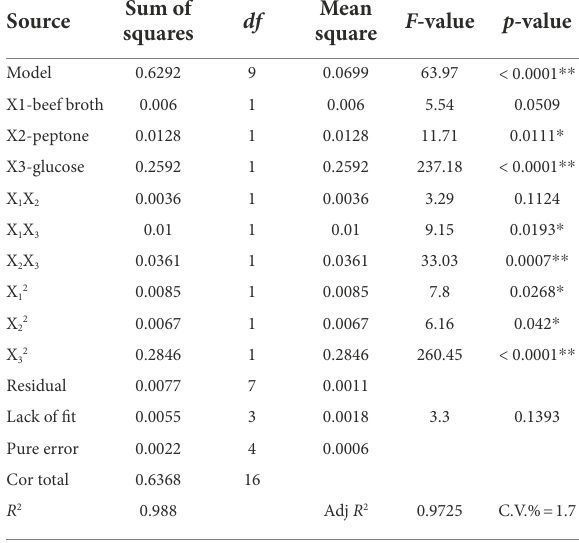
TABLE 5 ANOVA of the fitted polynomial quadratic